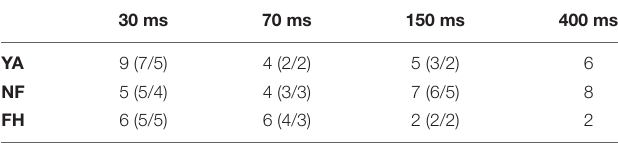
Numbers in parenthesis are the final number of participants in each group included for time-frequency analysis / the final number of participants in each group included for PAC